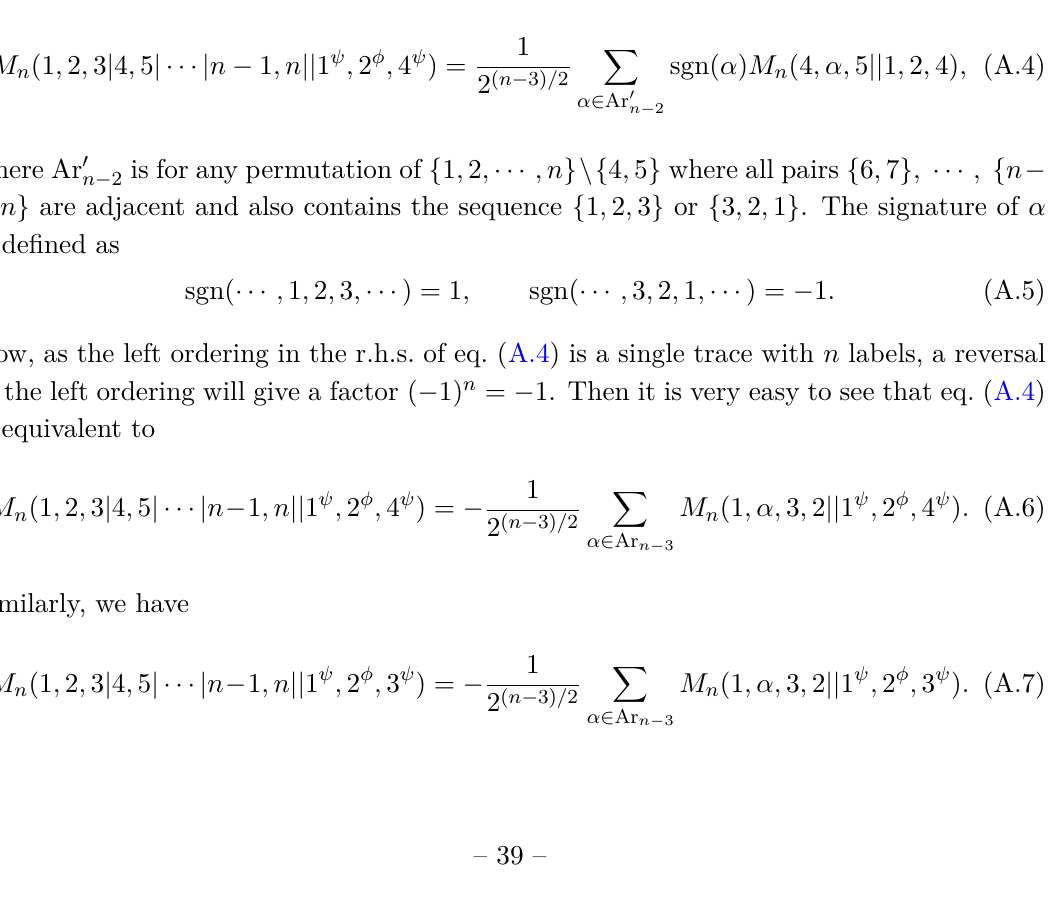
are adjacent, while 1 and 3 sandwich 2 . The only complication is that there is an extra minus sign for terms with { 3 , 2 , 1 } instead of { 1 , 2 , 3 } . We